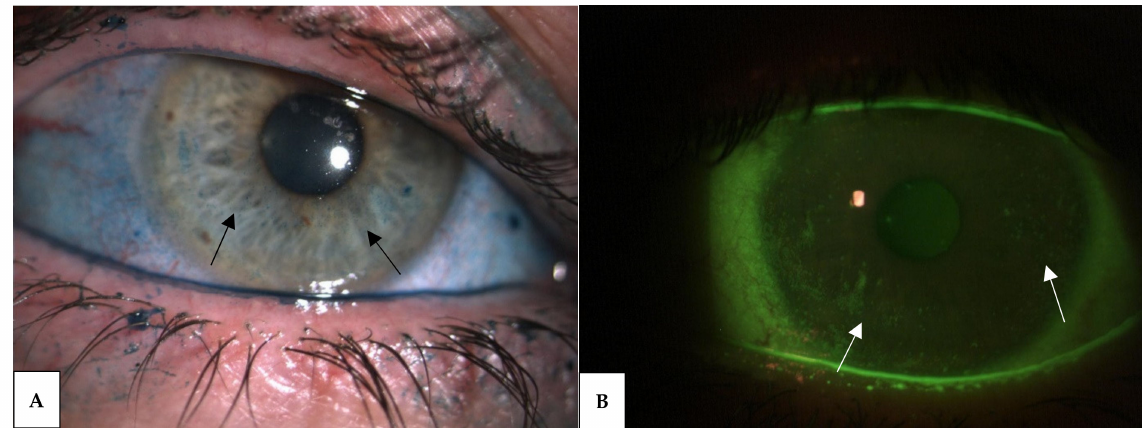
Figure 3. Punctate epithelial keratopathy (black and white arrows) highlighted by staining with Lissamine Green (image A ) and Sodium Fluorescein (image B ) in the same patient’s